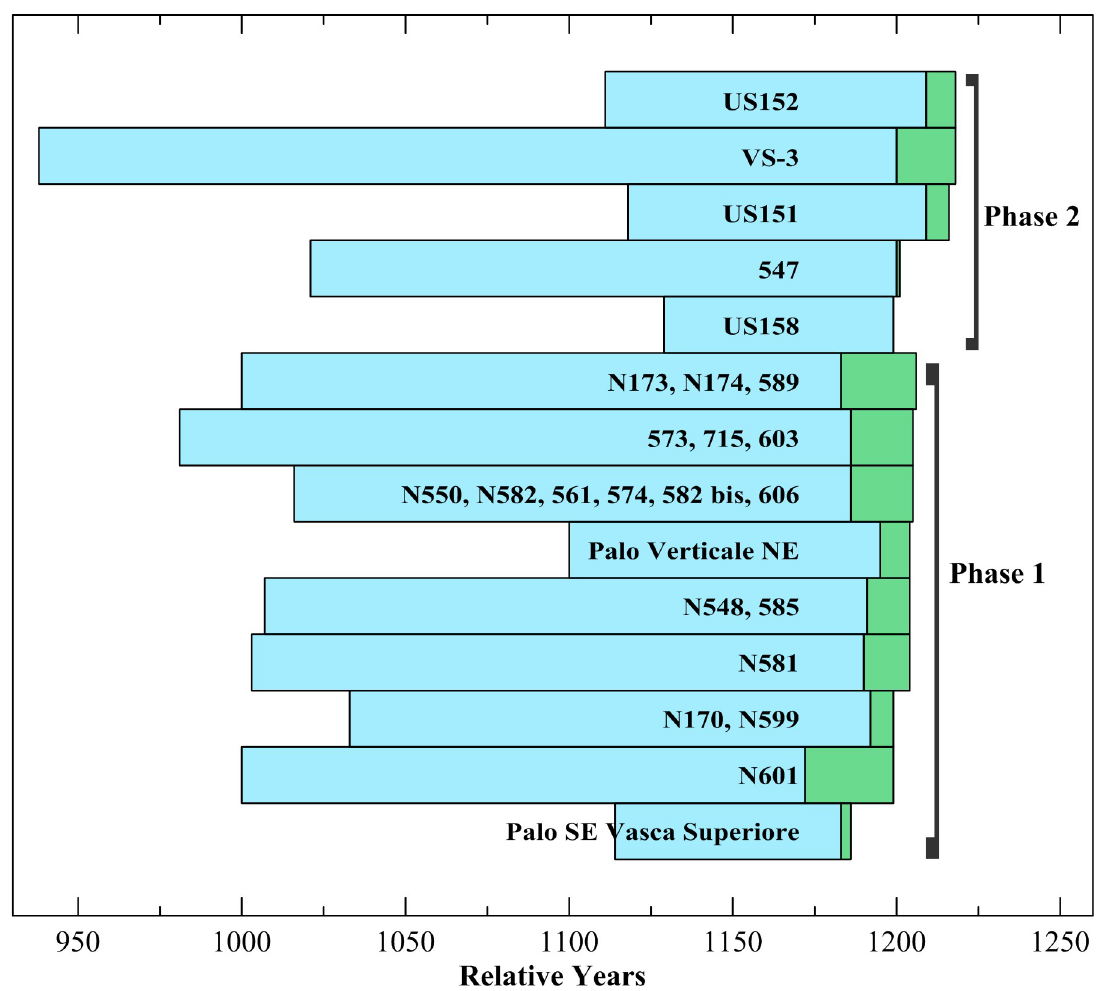
Fig 13. Bargraph showing the crossdated placements of the timbers from the two phases identified among the Noceto samples.